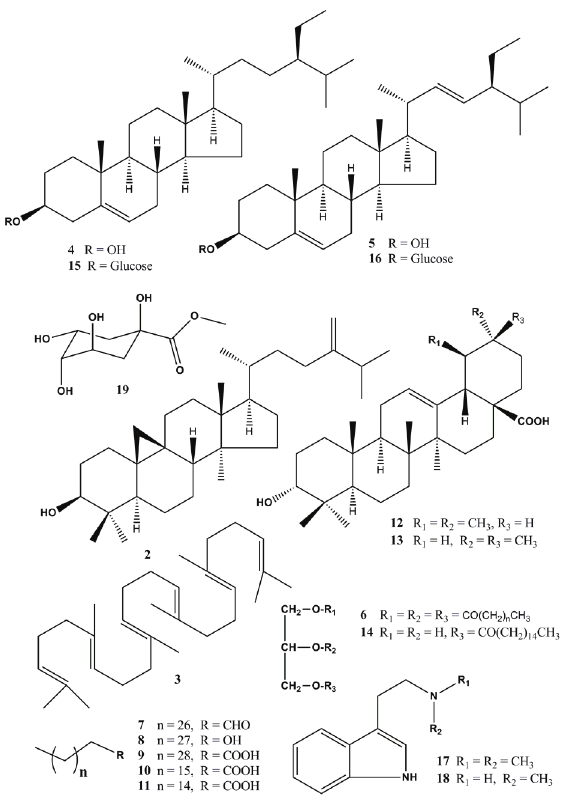
Figure 1 - Chemical structures of some constituents isolated from leaves of P. viridis